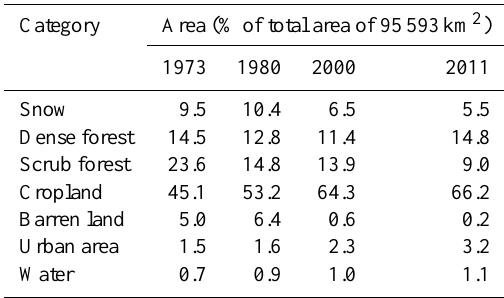
Table 3. LU analysis of UGB for years 1973, 1980, 2000 and